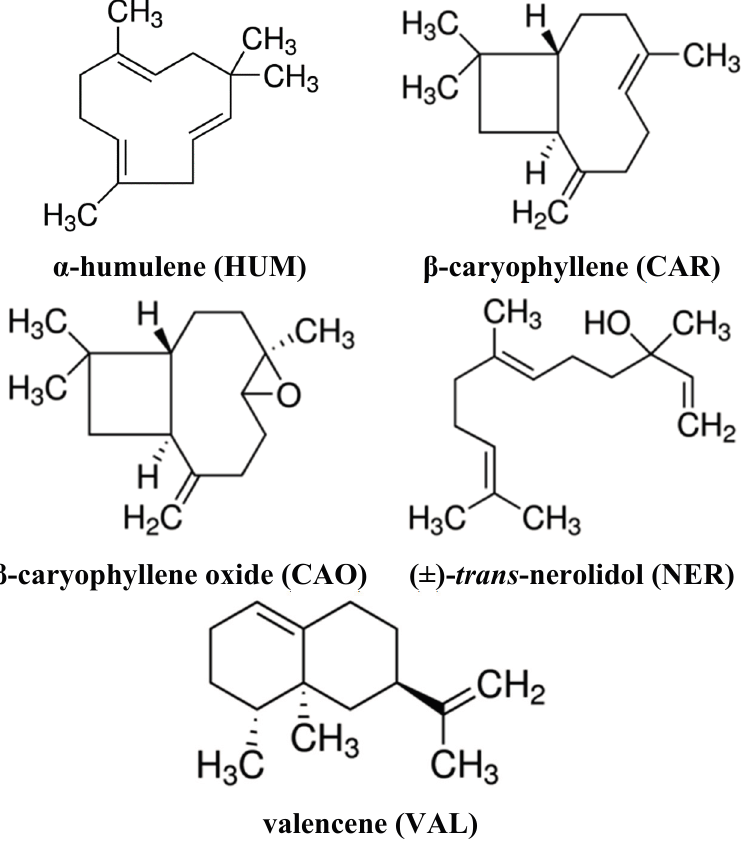
Figure 1. Structures of the tested